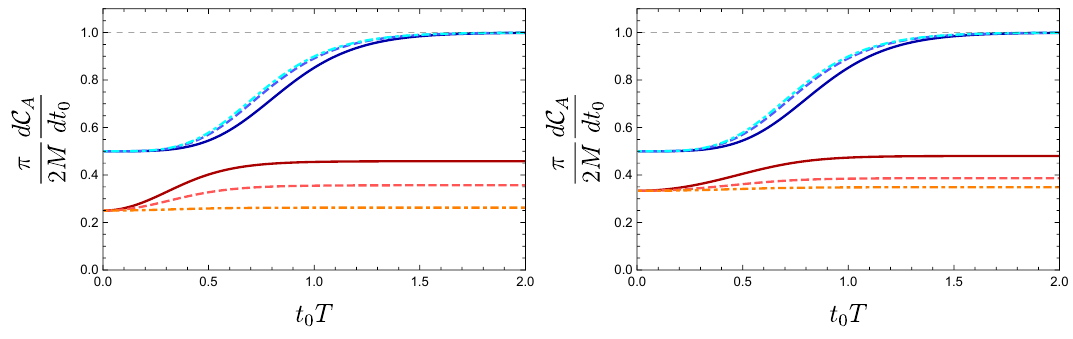
Figure 4 . The growth rate for the complexity in d = 3 (left) and d = 4 (right) and spherical geometry ( k = +1), evaluated without (red and orange curves) and with (blue and cyan curves) the boundary counterterm (2.30). In both case, we evaluate the growth rate for temperatures TL = 0 : 35 (solid), TL = 0 : 5 (dashed) and TL = 2 : 0 (dot-dashed) in the left and TL = 0 : 5 (solid), TL = 0 : 8 (dashed) and TL = 1 : 5 (dot-dashed) in the right (cid:12)gure. In both dimensions, d counterterm) starts at the value of the planar rate of change given by eq. (3.32) and